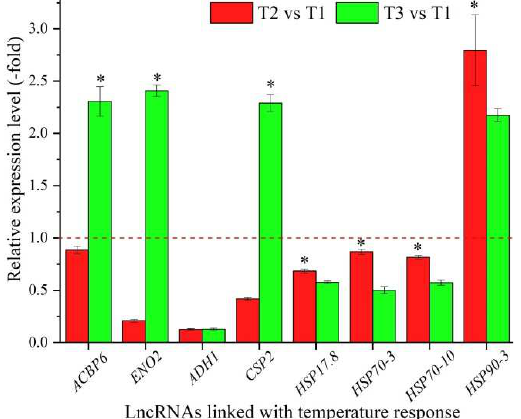
Figure 4. The expression levels of coexpressed mRNAs of lncRNAs linked with temperature response in A. sinensis at T2 vs. T1 and T3 vs. T1, as determined by qRT-PCR. The “*” represents a significant difference at p < 0.05 level between T2 vs. T1 and T3 vs. T2 for the same gene.